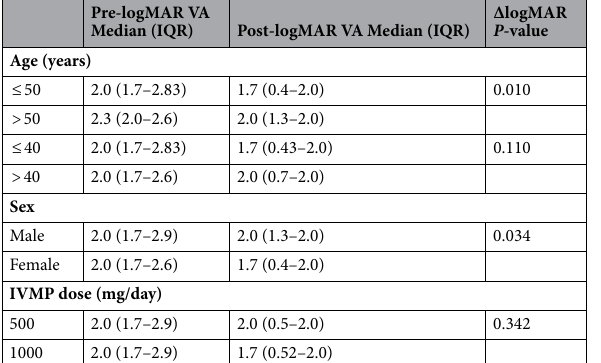
Pre-logMAR VA Median